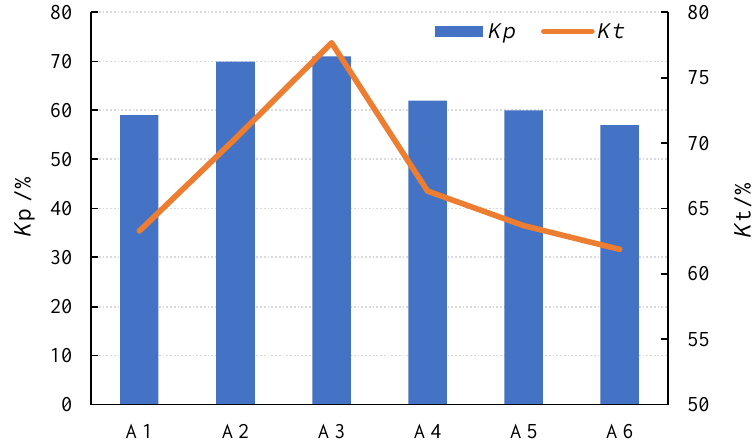
Figure 7. Changes in K t and K p of specimens with SL/FA.